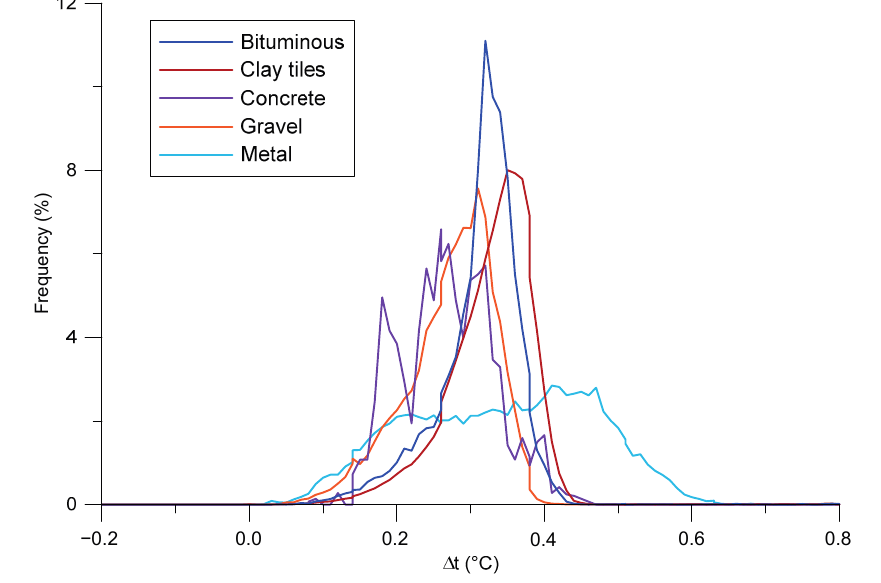
Figure 8. Statistics on the temperature differences for each class, resulting from a decrease by 1% of the emissivity values listed in Table